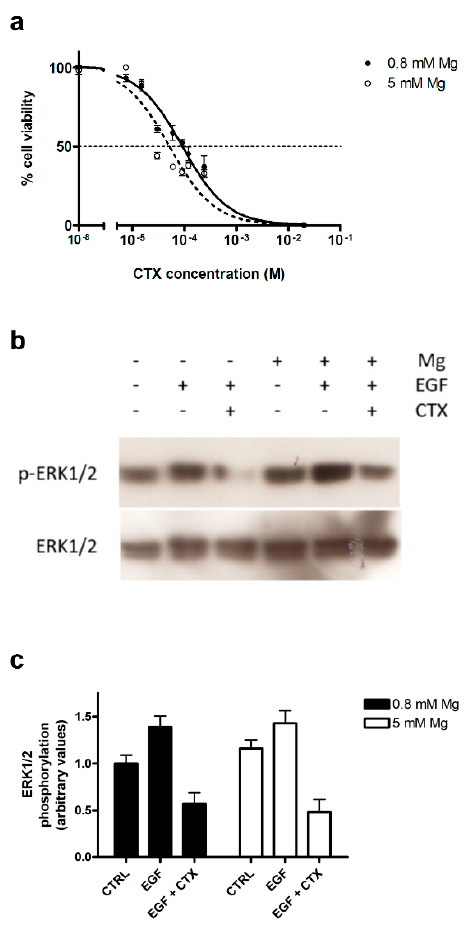
Figure 3. Mg supplementation does not affect cancer cell sensitivity to CTX. ( a ) A representative dose-response curve of CaCo-2 cells exposed to CTX (24 h) in control medium (0.8 mM of MgSO 4 , solid line and circles) or Mg-supplemented medium (5 mM of MgSO 4 , dotted line and open circles). ( b ) Phosphorylation of extracellular signal-regulated kinase (ERK) 1/2 in CaCo2 cells challenged for 24h with EGF (10 ng/mL) with or without CTX (70 μ g/mL) in control (0.8 mM of MgSO 4 ) or Mg-supplemented (5 mM of MgSO 4 ) medium, as assessed by Western blot analysis; a representative blot is shown. ( c ) Quantification of ERK1/2 phosphorylation by Western blot densitometry, normalized to total ERK1/2 levels ( n = 3, mean ± SD). Two-way ANOVA indicated a very significant effect ( p < 0.001) of EGF/CTX treatment, while Mg concentration had no significant effect ( p = 0.70). The effect of CTX on unstimulated cells in control or Mg-supplemented medium is reported in Figure S3.